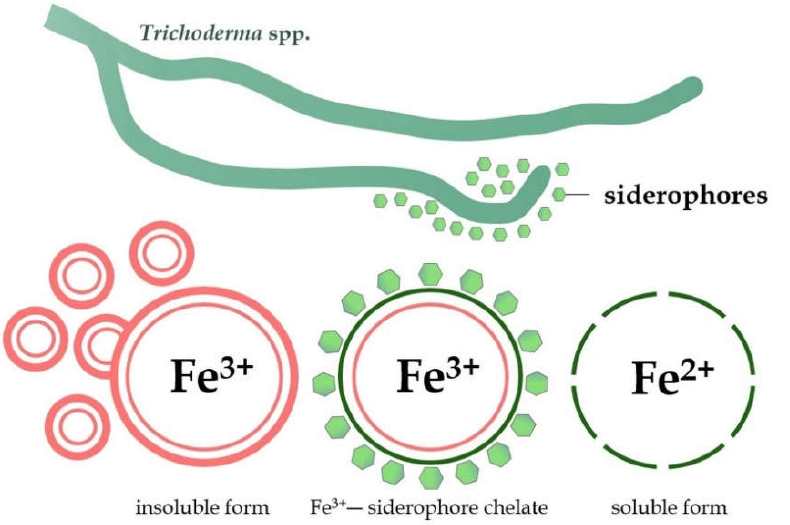
Figure 4. Transformation of the insoluble form of iron (Fe 3+ ) into a soluble and easily assimilate form (Fe 2+ ) by siderophores produced by Trichoderma fungi.